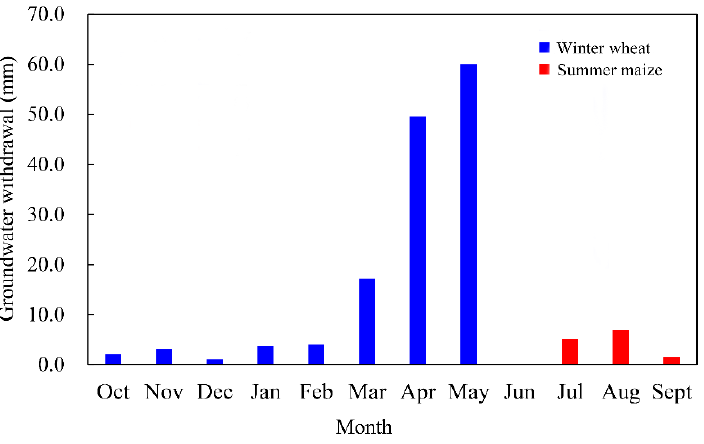
Figure 9. Monthly average groundwater withdrawal for winter wheat and summer maize crops.